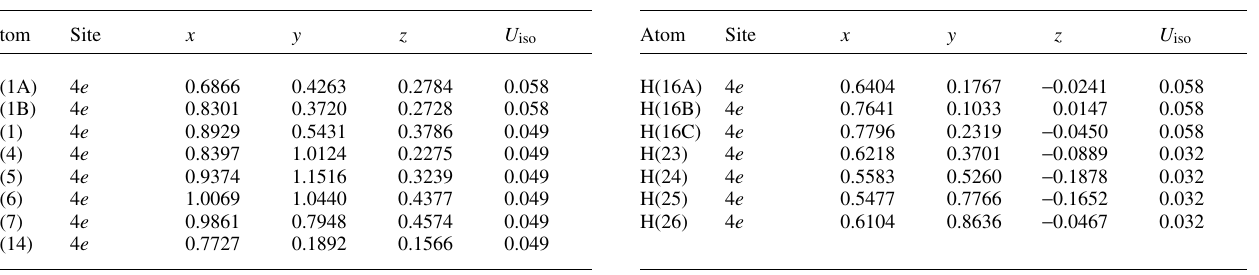
Table 2. Atomic coordinates and displacement parameters (in Å 2 )